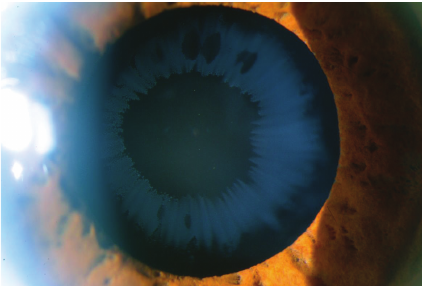
Figure 1: Pseudoexfoliative deposits on IOL in OD.